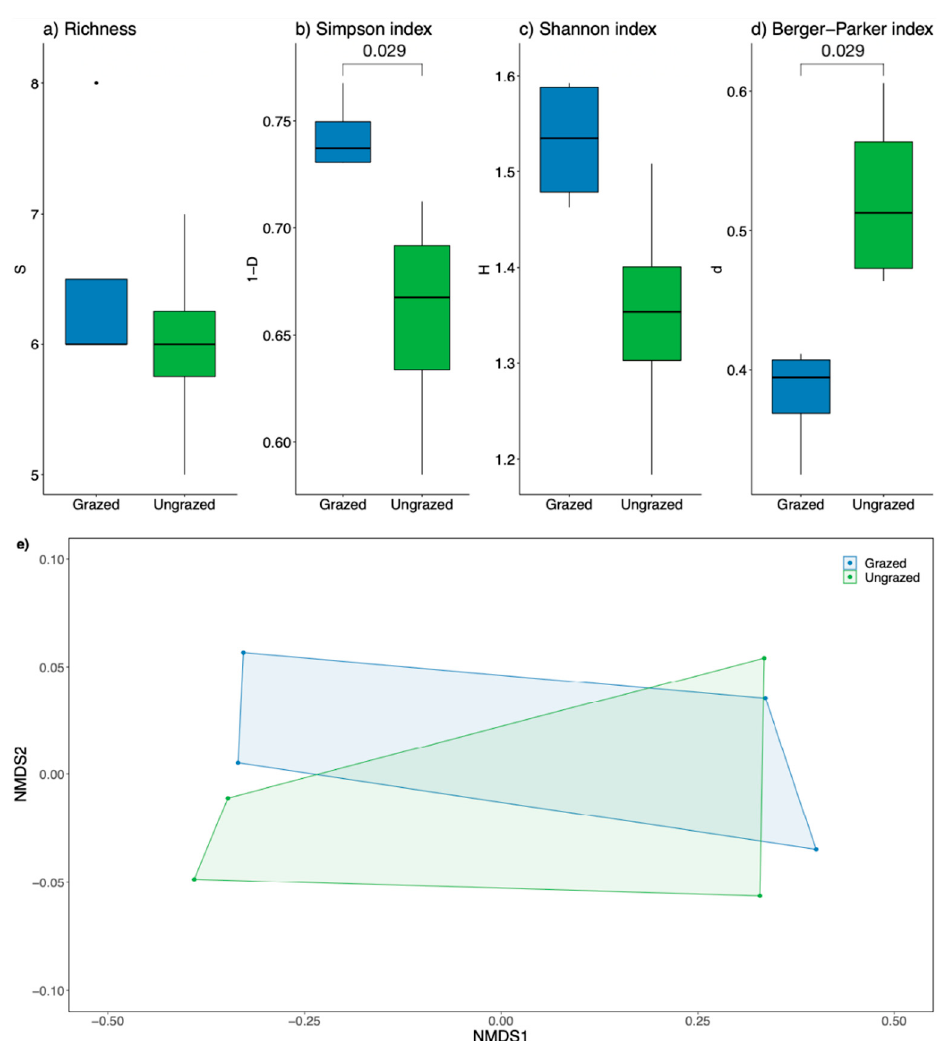
Figure 3. Diversity analysis of grazed (blue) and ungrazed (green) grassland plots. ( a ) Richness, ( b ) Simpson index, ( c ) Shannon index, and ( d ) Berger–Parker index; bar plots represent the interquartile range with the median (bold black line), the outliers (circles), the whiskers (vertical lines), and the minimum and maximum (end of vertical lines). ( e ) NMDS ordination showing the two